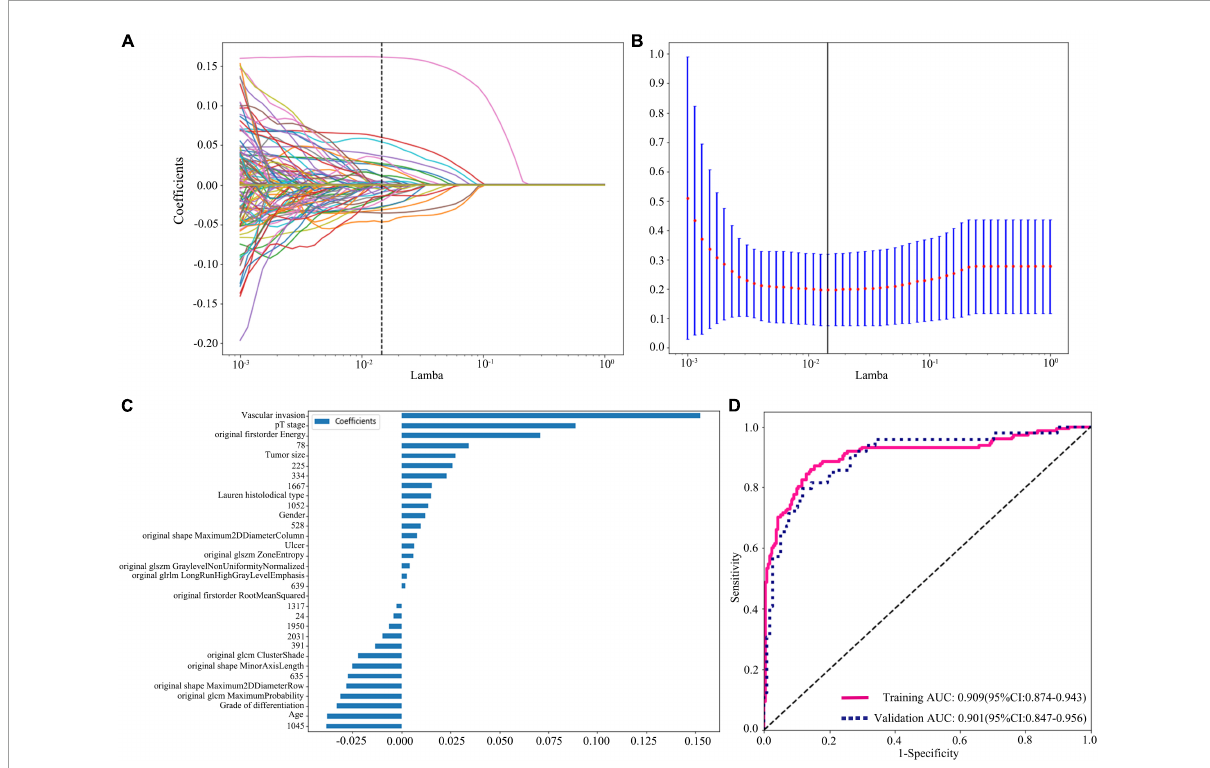
FIGURE3 Radiomics + DTL (Resnet152) + clinical features dimension reduction and performance of the model. (A) LASSO coefficient profiles of the features. Different color line shows corresponding coefficient of each feature. (B) Tuning parameter ( λ ) selection in LASSO model. (C) Selected features weight coefficients. (D) Area under the curve (AUC) of predictive model based on radiomics + DTL (Resnet152) + clinical features in training and validation cohorts. DTL, deep transfer learning; LASSO, least absolute shrinkage and selection